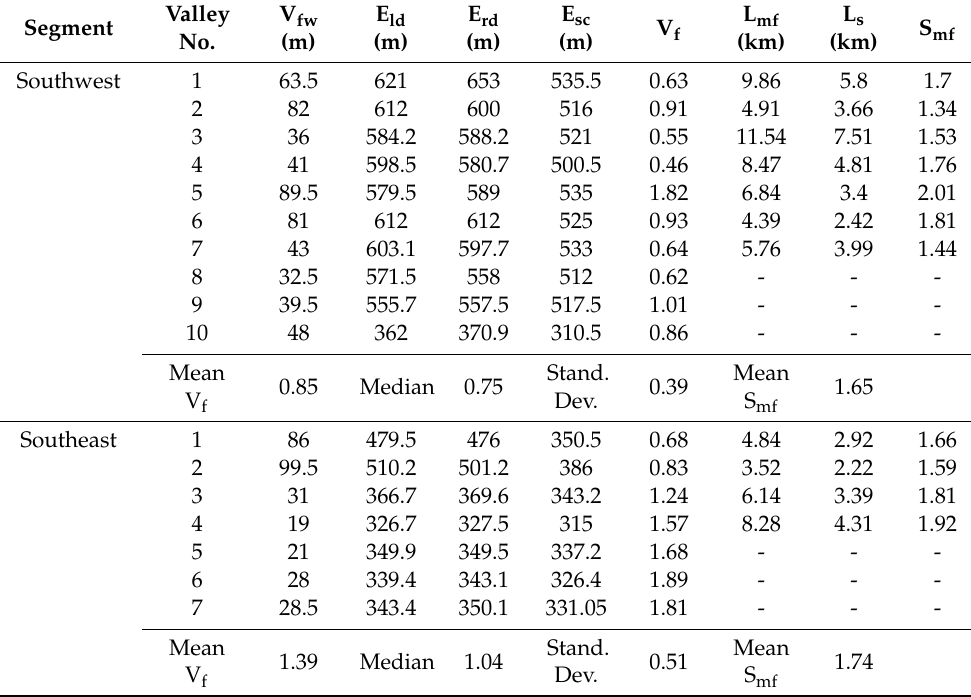
Table 1. S mf and valley floor width to height ratio (V f ) values were calculated across the Khirgi Thrust. S mf for two di ff erent mountain front segments, i.e., southwest and southeast. The mean values for each segment was also indicated. Values of V f (valley floor width to height ratio) along the major streams traversing perpendicular to the anticlinal structures in the study area where V fw is the width of the valley floor, E ld is an elevation on the left side of the valley floor, E rd is the elevation on right side of the valley floor, and E sc is the elevation on the valley floor. All calculations were limited to 500–1500 m of the mountain front and were constrained to the same lithology. Mean, median and standard deviation were calculated to better distribute the